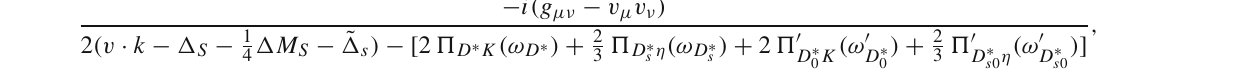
Fig. 1a of scalar mesons. Since ω P ∼ M P ∗ ∼ M − M − ( M − M ) + · · · and M ω (cid:3) P P ∗ 0 P (cid:3) 1 P (cid:3) 1 P (cid:3) 1